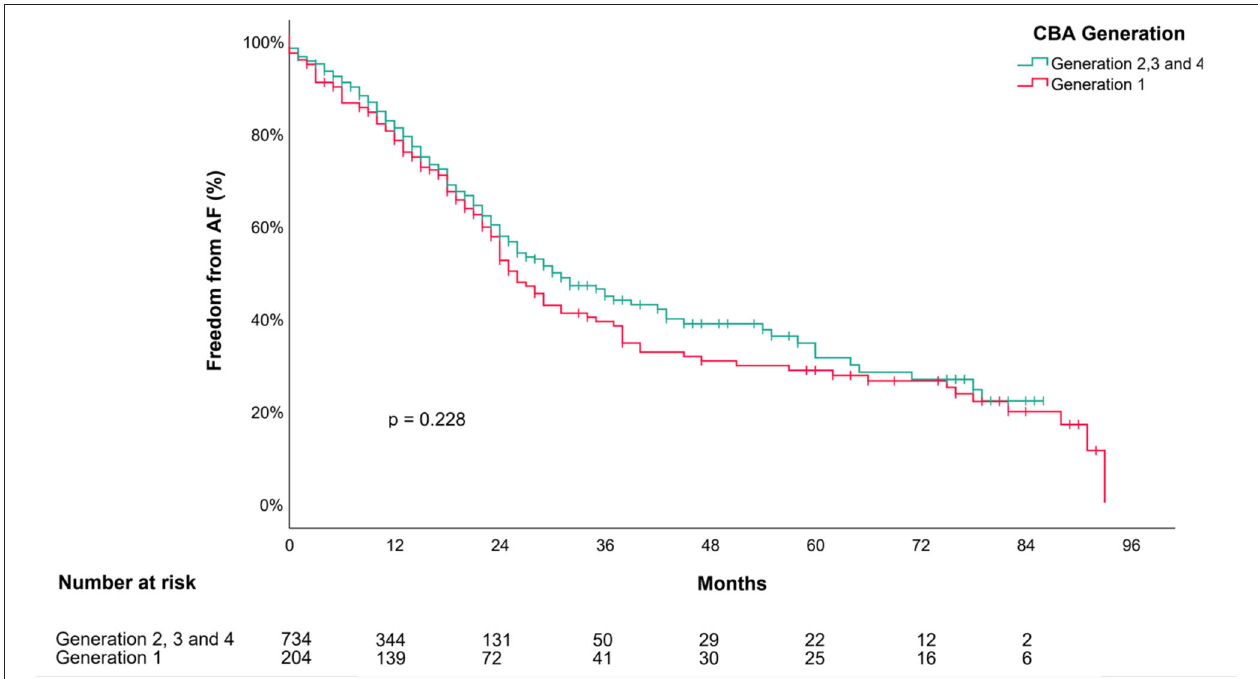
FIGURE 3 | Outcome of cryoballoon ablation in persistent AF after a single procedure. Kaplan–Meier Survival Curve depicts estimates for “Freedom from AF/AT” after a single cryoballoon ablation stratified following the first (CBG1; in red color) or an advanced cryoballoon generation (CBG2, CBG3, or CBG4; in Turquoise color) of the balloon. P -value is provided for the log-rank comparison of the curves. AF, atrial fibrillation; CBA, cryoballoon ablation.